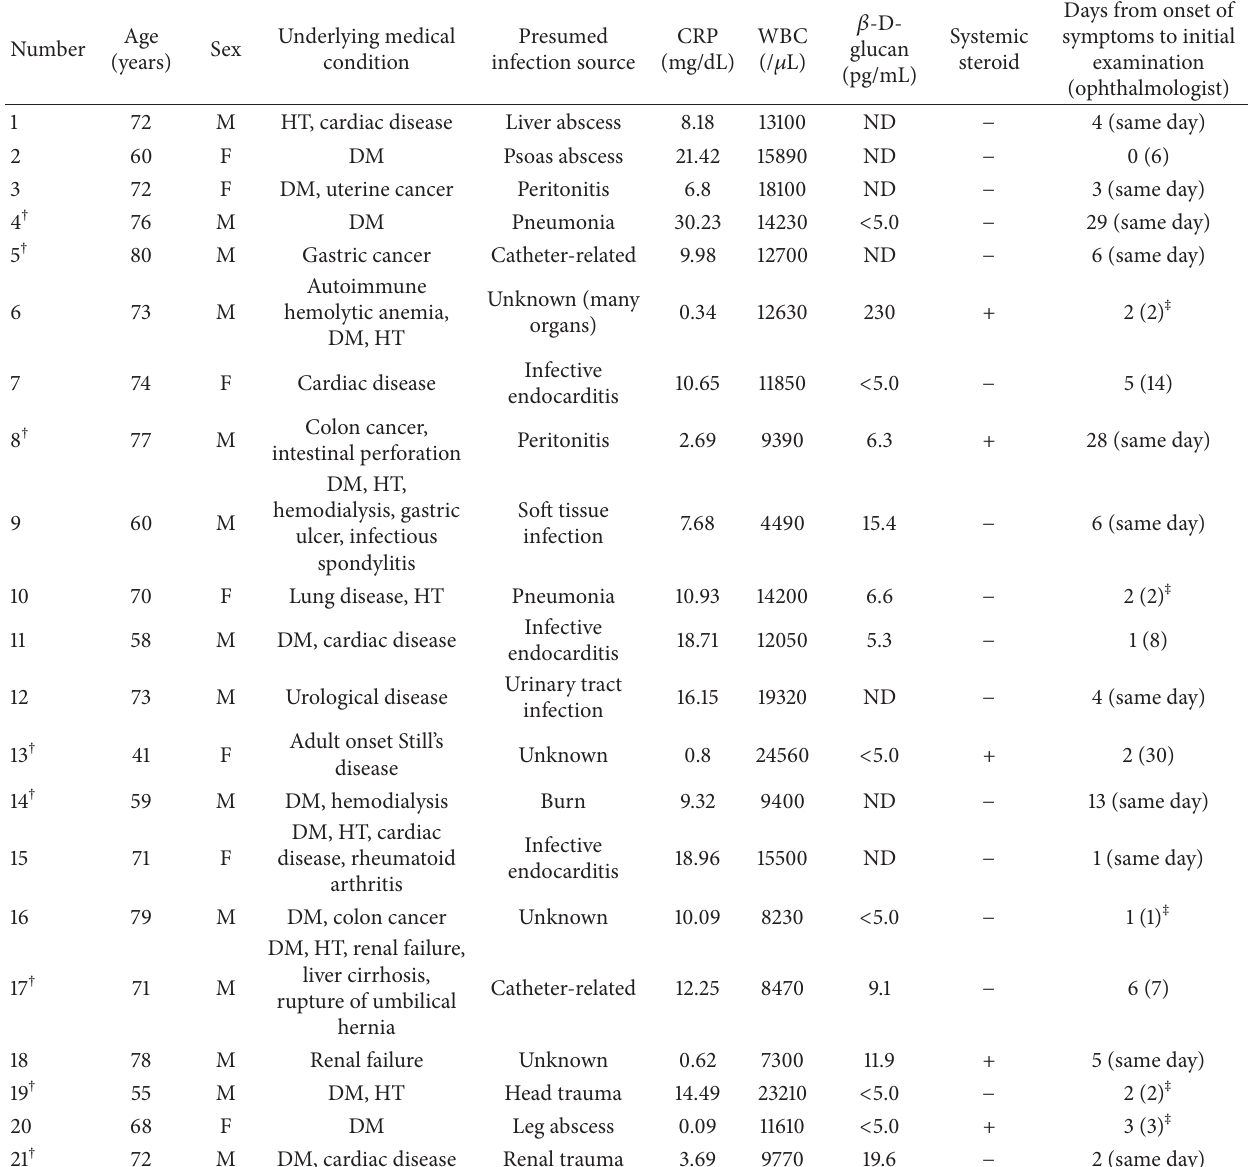
Table 1: Patient characteristics and systemic